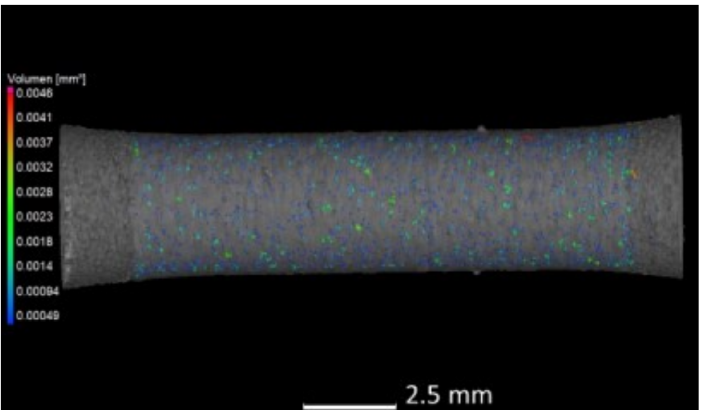
Figure 3. Exemplary reconstructed model of the testing area of an A-specimen with pore distribution and coloured pore sizes.